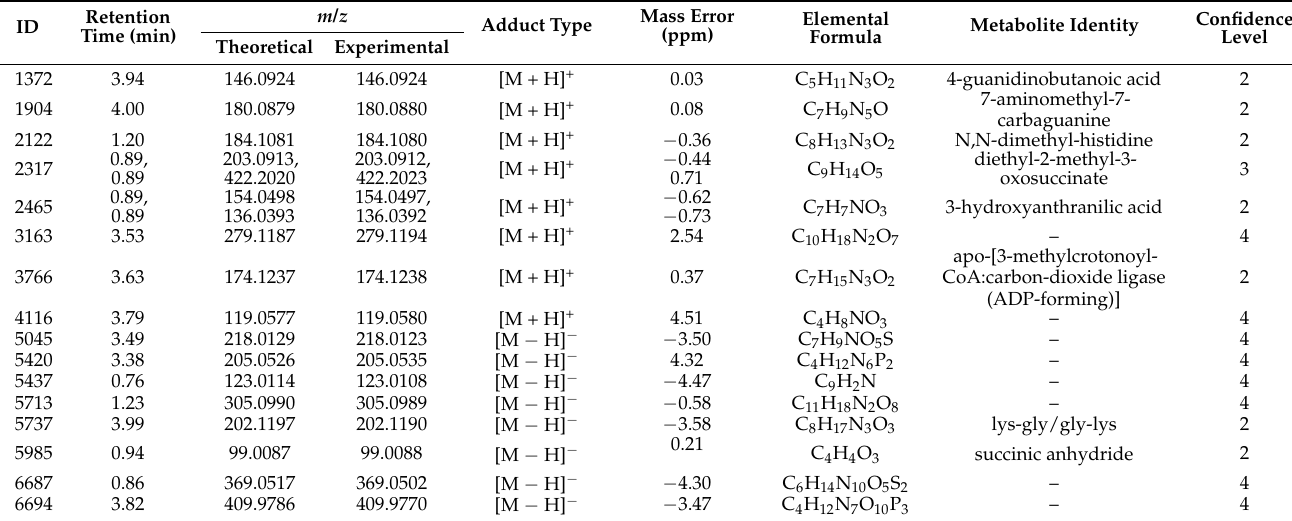
N-alpha-dimethyl-L-histidine, diethyl-2-methyl-3-oxosuccinate, 3-hydroxyanthranilic acid, apo-[3-methylcrotonoyl-CoA:carbon-dioxide ligase (ADP-forming)], lys-gly/gly-lys, and succinic anhydride. All these markers were detected by LC-MS. Random forest (RF), adaptive boosting (AdaBoost), support vector machine with radial basis function kernel (SVM-RBF), logistic regression, and a voting ensemble combining all four methods were used for stratification under ten-fold cross-validation conditions. Figure S4 shows the ML predictions for RCC staging using the 16-metabolite panel and various classifiers. Overall, voting ensemble models gave the best predictions, with an AUC of 0.95, accuracy of 86%, sensitivity of 80%, and specificity of 91%. Table 3. Compound annotation for the 16-metabolite panel ( m / z = mass-to-charge ratio, min = minutes, ppm = part per million).